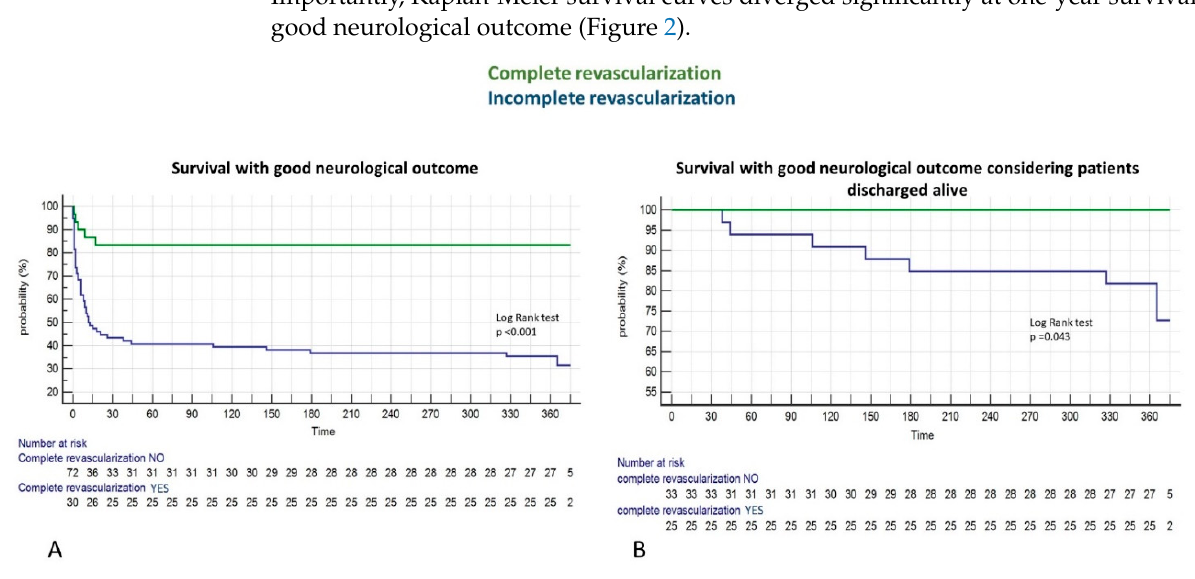
Figure 2. Kaplan-Meier survival curves for the overall population ( A ) and the patients discharged alive ( B ).